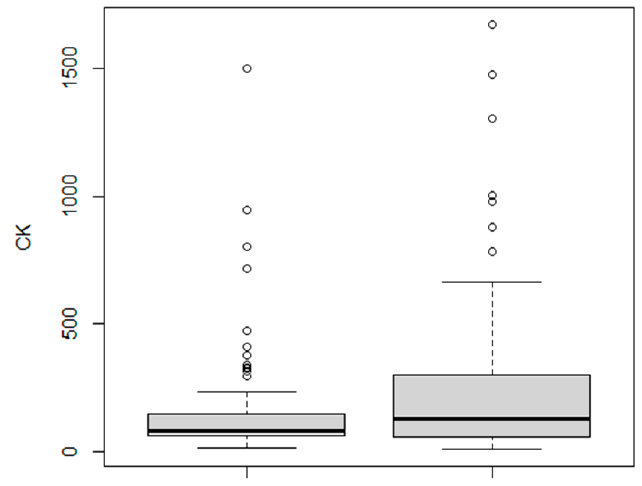
Figure 1. Higher CK levels in patients with “severe” (right) compared to “mild” (left) COVID-19. CK, creatine kinase, U/L.